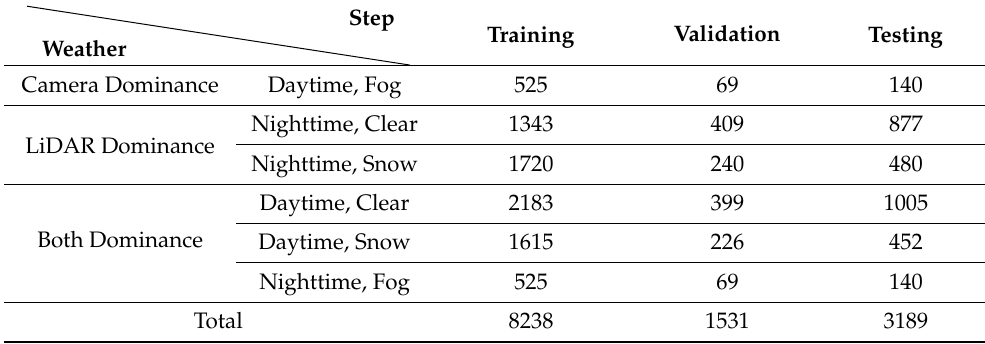
Table 1. Number of